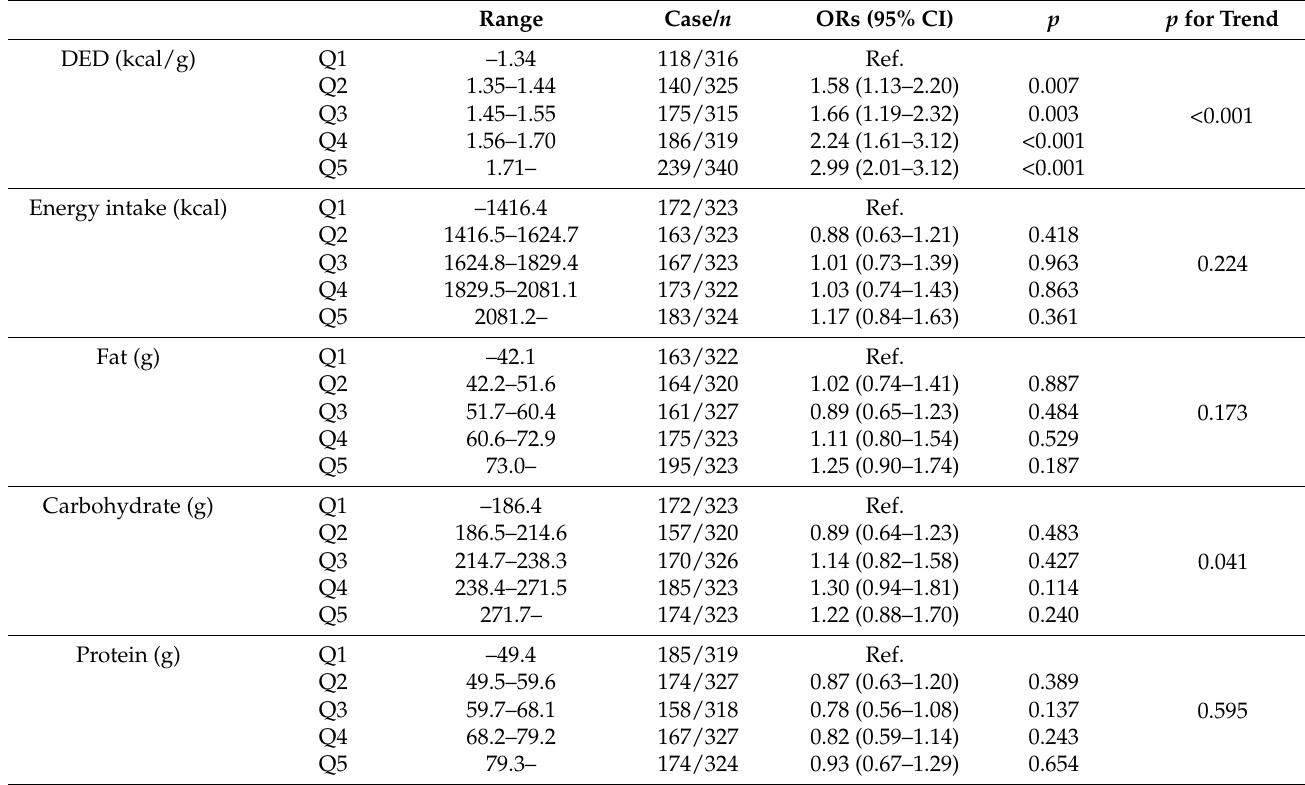
Table 2. Odds ratios (ORs) for obesity (BMI ≥ 25) with 95% CIs for energy density (DED), intake of energy, and macronutri- ents according to quintiles. Range Case/ n ORs (95% CI) p p for Trend DED